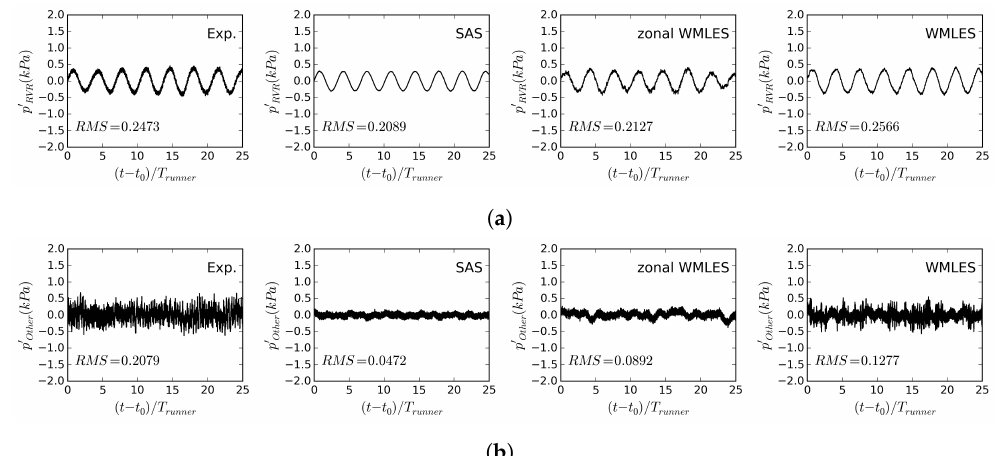
Figure 9. Different components of pressure fluctuations at Probe 2 (shown in Figure 2a), ( a ) due to the rotation of RVR, ( b ) due to other sources than